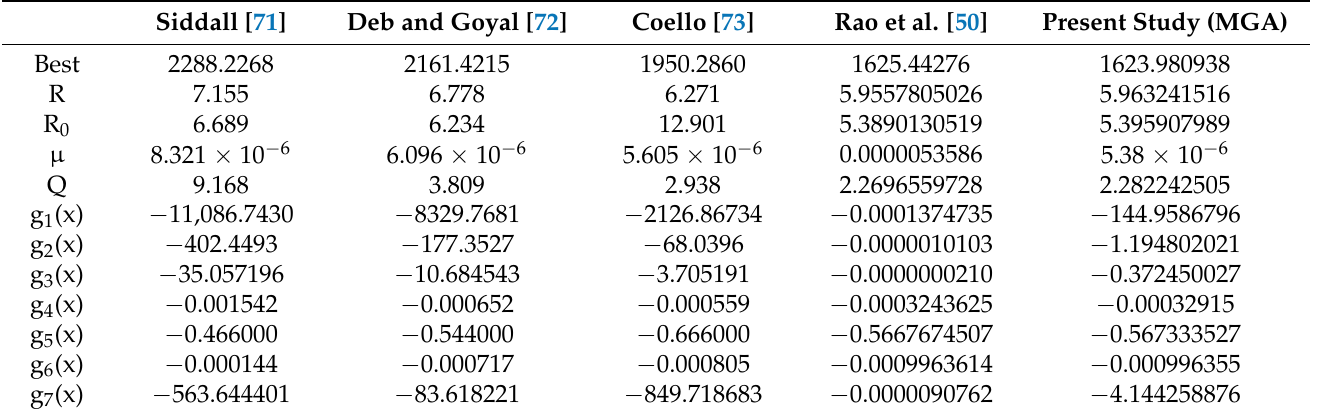
Table 16. Comparison of the best solutions for the hydrostatic thrust bearing design problem.